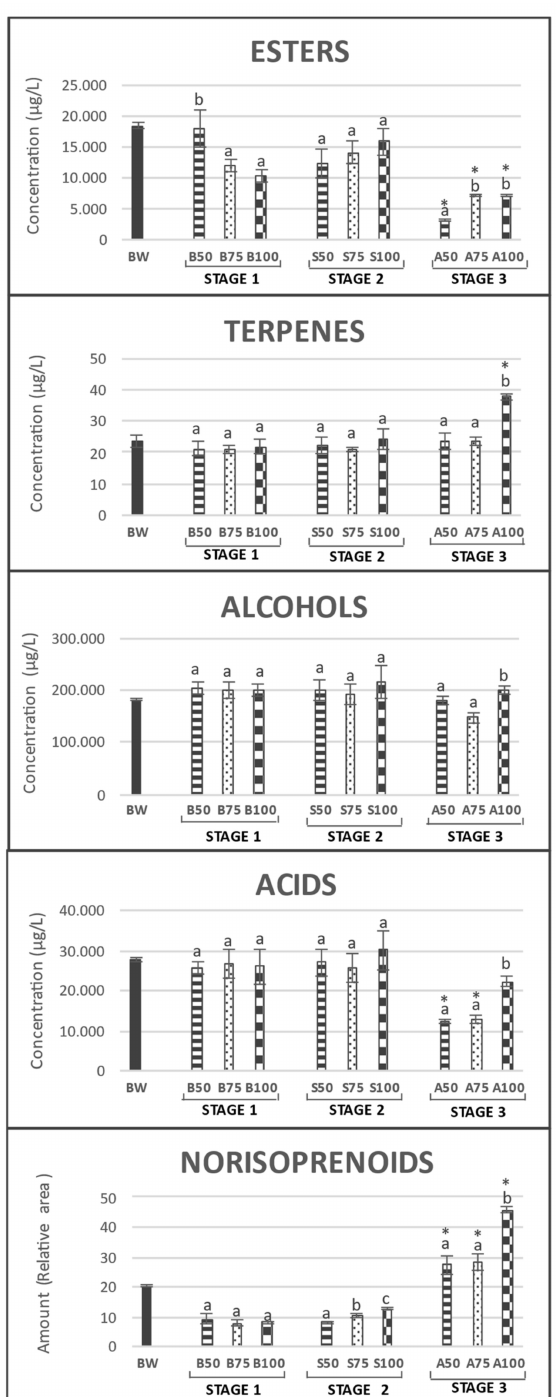
Figure 2. Total amounts of esters, alcohols, terpenes, acids, and norisoprenoids present in every Scheme 50. B75, B100 (wines before second fermentation with the first addition of bentonite); S50, S75, S100 (sparkling wines after second fermentation with the second addition of bentonite); A50, A75, A100 (sparkling wines after 9 months of aging on lees). Bars with different superscript letters indicate statistically significant differences ( p < 0.05) by Tukey test among the samples belonging to the same stage *: statistically significant differences ( p < 0.05) by Tukey test with the same treatment of the previous